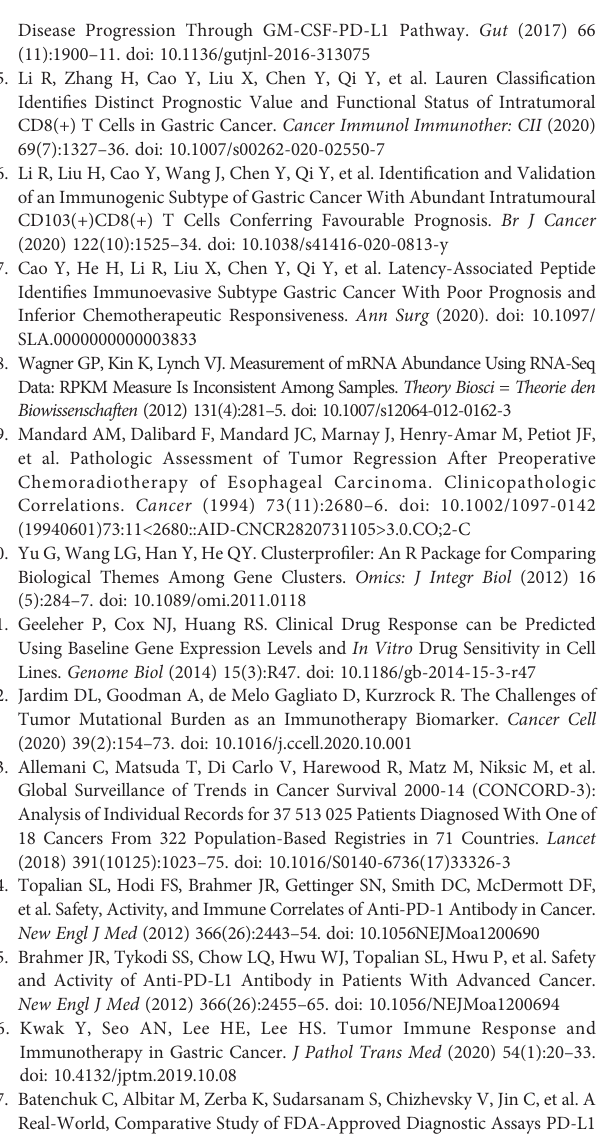
Supplementary Figure 1 | Consensus matrixes of all GC samples for each k (k = 2 – 5), displaying the clustering stability using 1000 iterations of hierarchical clustering. Supplementary Figure 2 | Venn diagram illustrating the number of DEGs among the two ICI clusters. Supplementary Figure 3 | Consensus matrixes of GC cohorts for each k (k = 2 – 5), displaying the clustering stability using 1000 iterations of hierarchical clustering based on the DEGs acquired. Supplementary Figure 4 | Flowchart of this